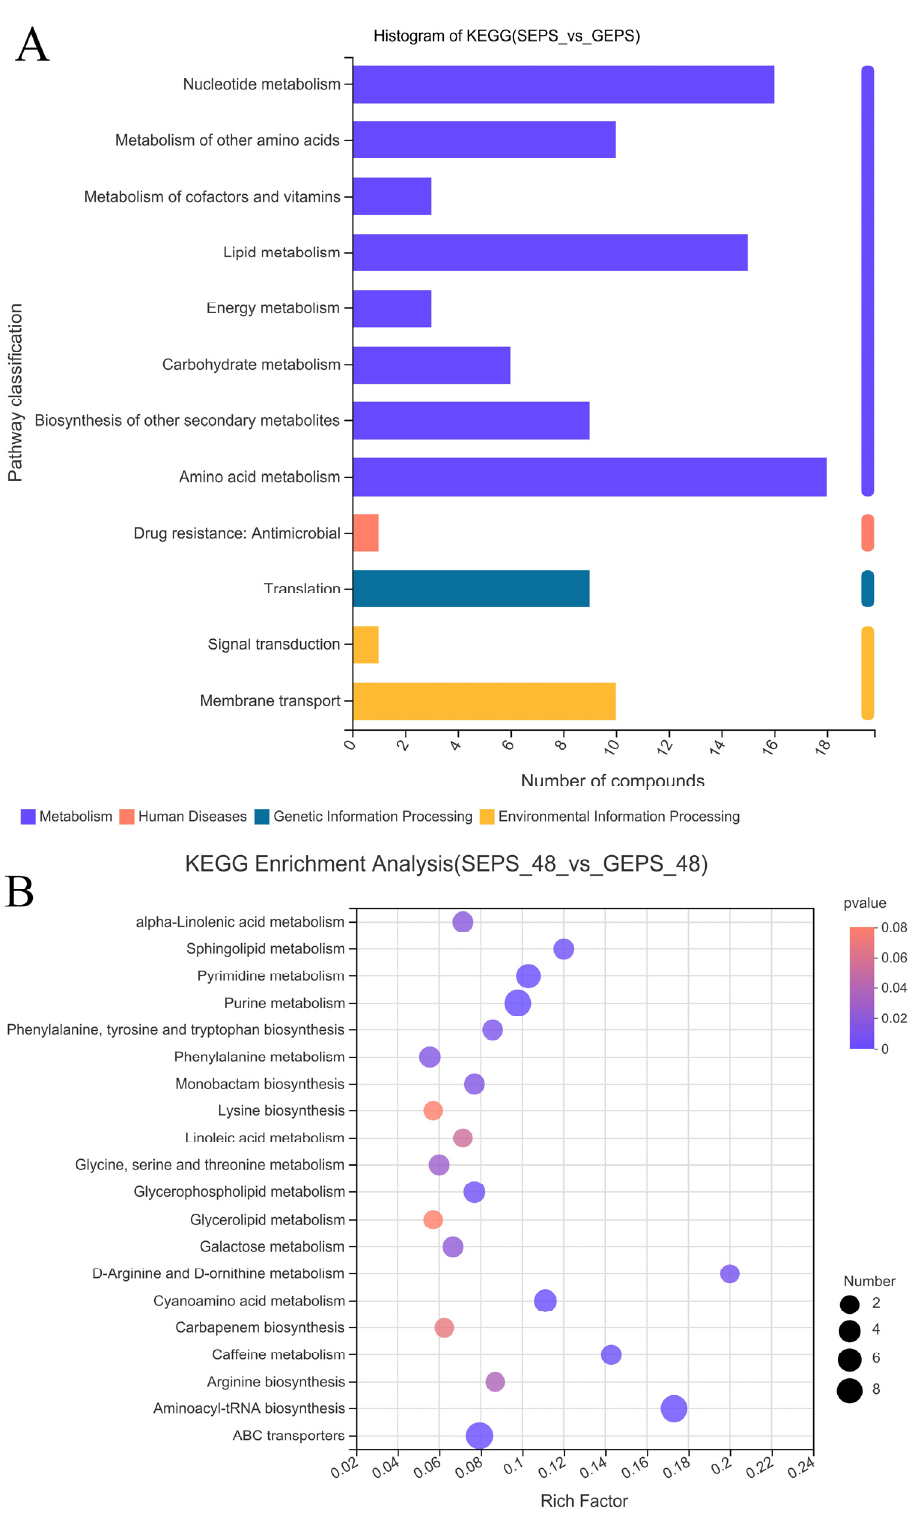
Figure 5. ( A ) KEGG annotation histogram of DEMs. ( B ) Enrichment analysis of DEMs between SEPS_48 and GEPS_48 comparison groups based on KEGG pathway. The color represents the p -value, and the size of the bubble represents the number of DEMs.